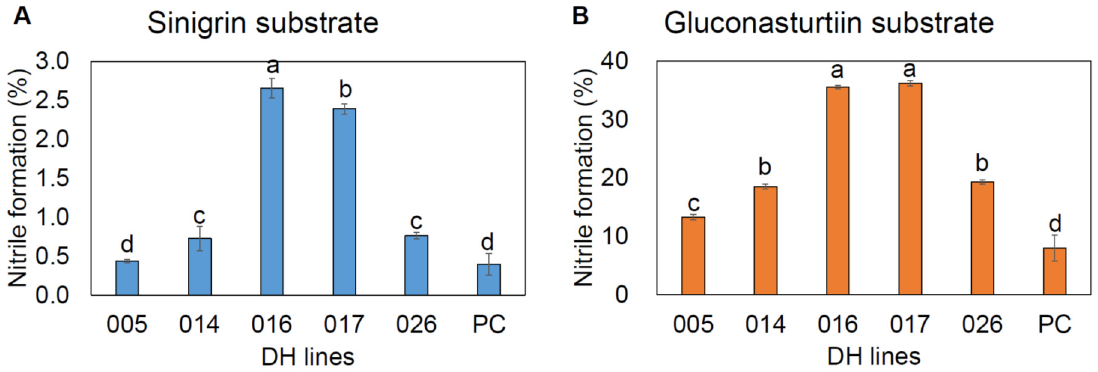
Figure 5. Percentage of nitrile formation in high GSL DH lines using sinigrin ( A ) and gluconasturtiin ( B ) as substrate. Lowercase letters above the error bar indicate significant differences among the accessions as determined by Tukey’s HSD test at p < 0.05.